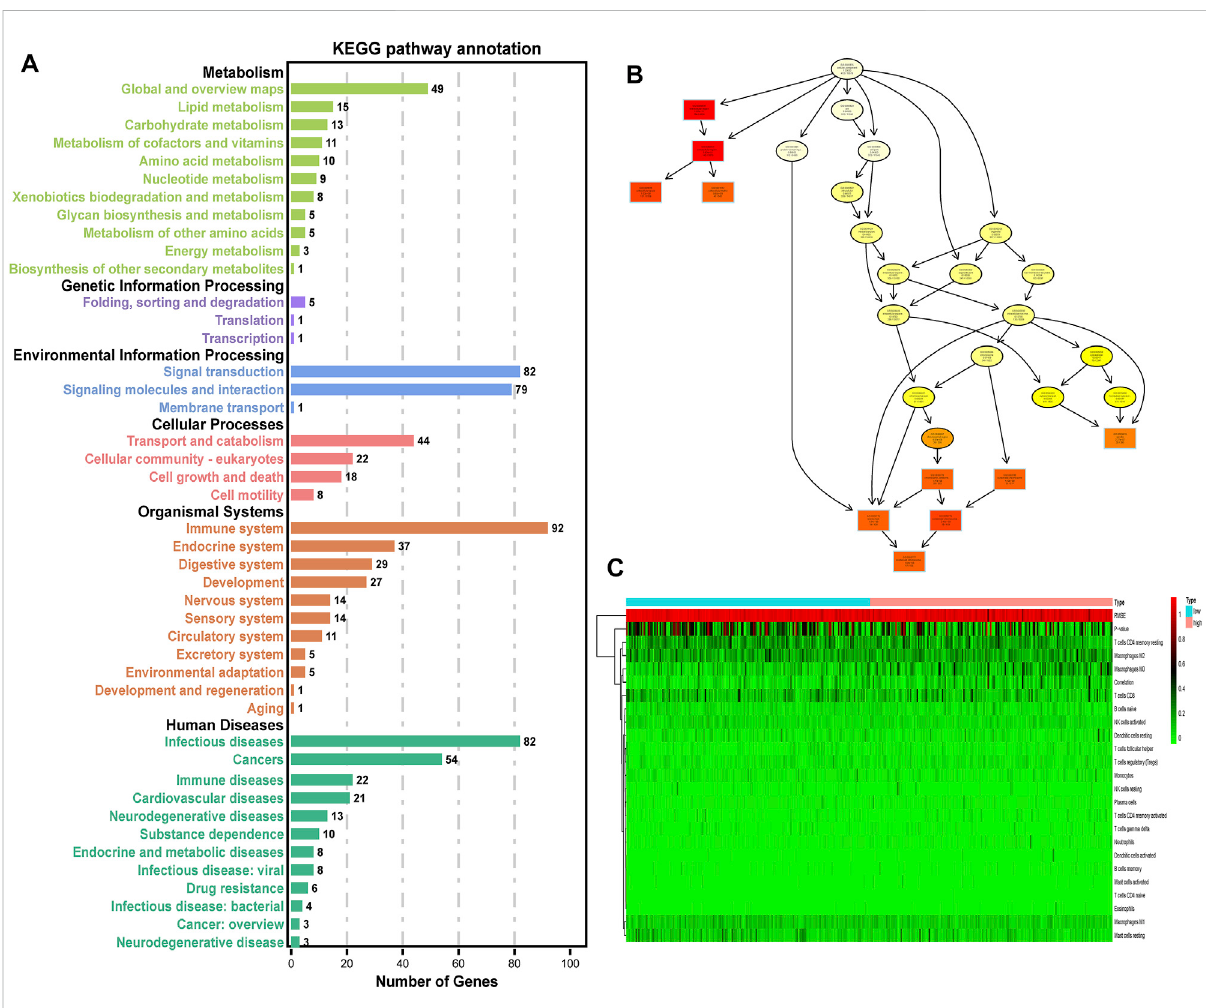
FIGURE 4 Selection of immune-related processes. (A) KEGG enrichment analysis of DEGs between high- and low-risk groups ( p < 0.05, q < 0.05). (B) Cellular component pathway of GO analysis. (C) Heatmap of 22 tumor immune-in fi ltrated cells for each HCC patient in TCGA cohort. Low: low-risk group of the ERG signature. High: high-risk group of the ERG